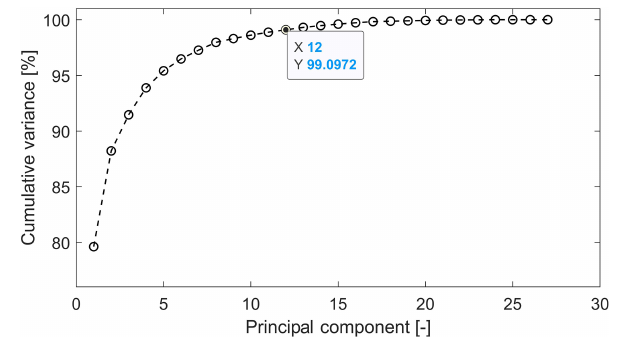
Figure 3. Cumulative variance explained by principal